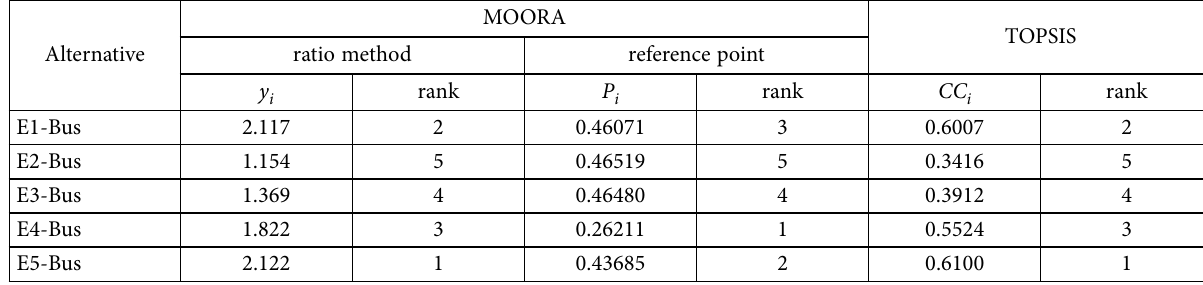
Table 6. Comparison of